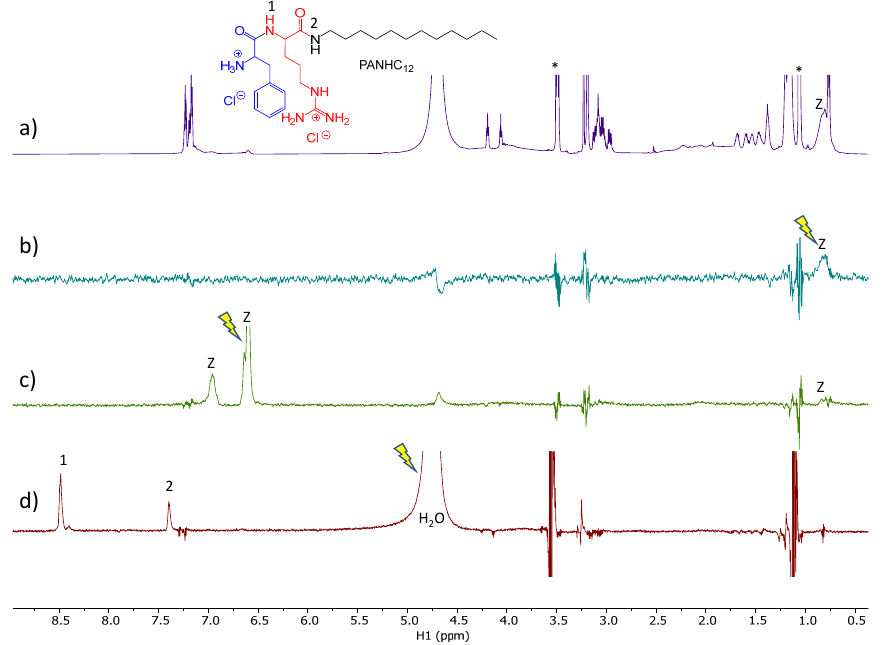
Figure 8. Spectra of PANHC 12 and zein mixture. ( a ) 1 H NMR, ( b , c ) STD off-on spectra with saturation at 0.82 and 6.6 ppm, respectively and ( d ) WaterLOGSY (mix. 500 ms). The arrow indicates the signal that is selectively on-saturated in STD spectra or selectively inverted in WaterLOGSY. The assignment is provided for some relevant protons giving STD or WaterLOGSY responses. The z refers to zein peaks and the asterisk denotes protons of ethanol impurity.